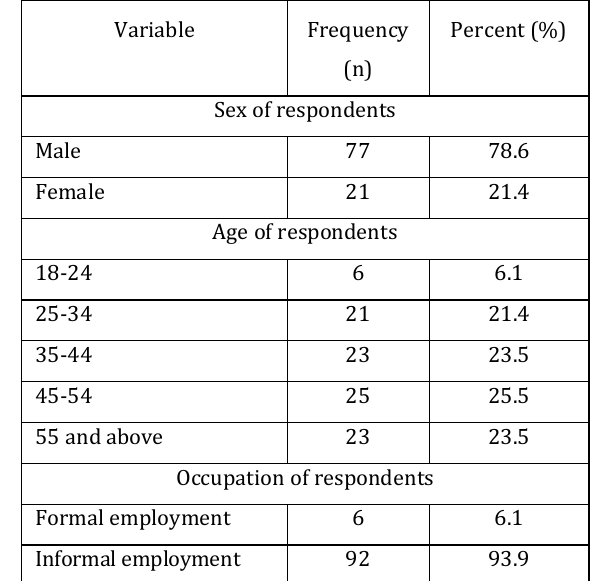
Table 1. General characteristics of